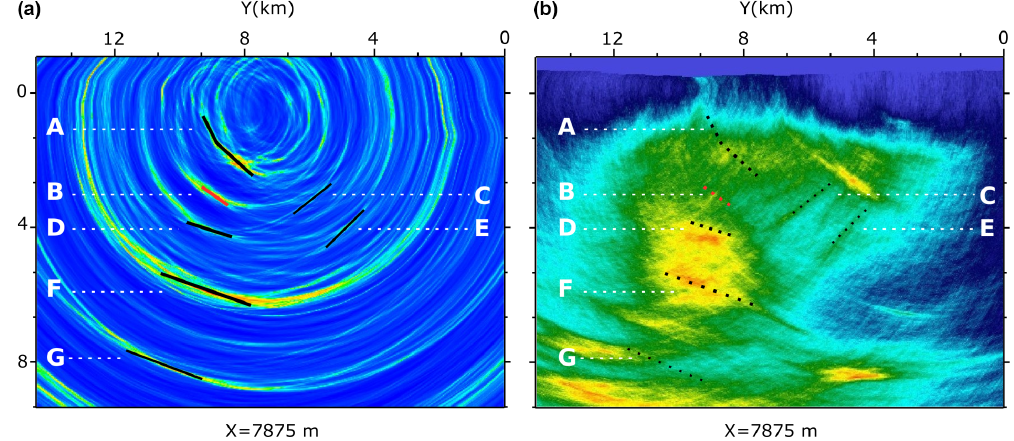
Figure 12. Comparison of the imaged structures in the coherency image (a) to the results of the active seismic survey in the area (b) . The thick solid lines show the reflectors with higher image value, the thin solid lines mark the reflectors with a lower image value, and the dashed black lines show them projected onto the active seismic image.